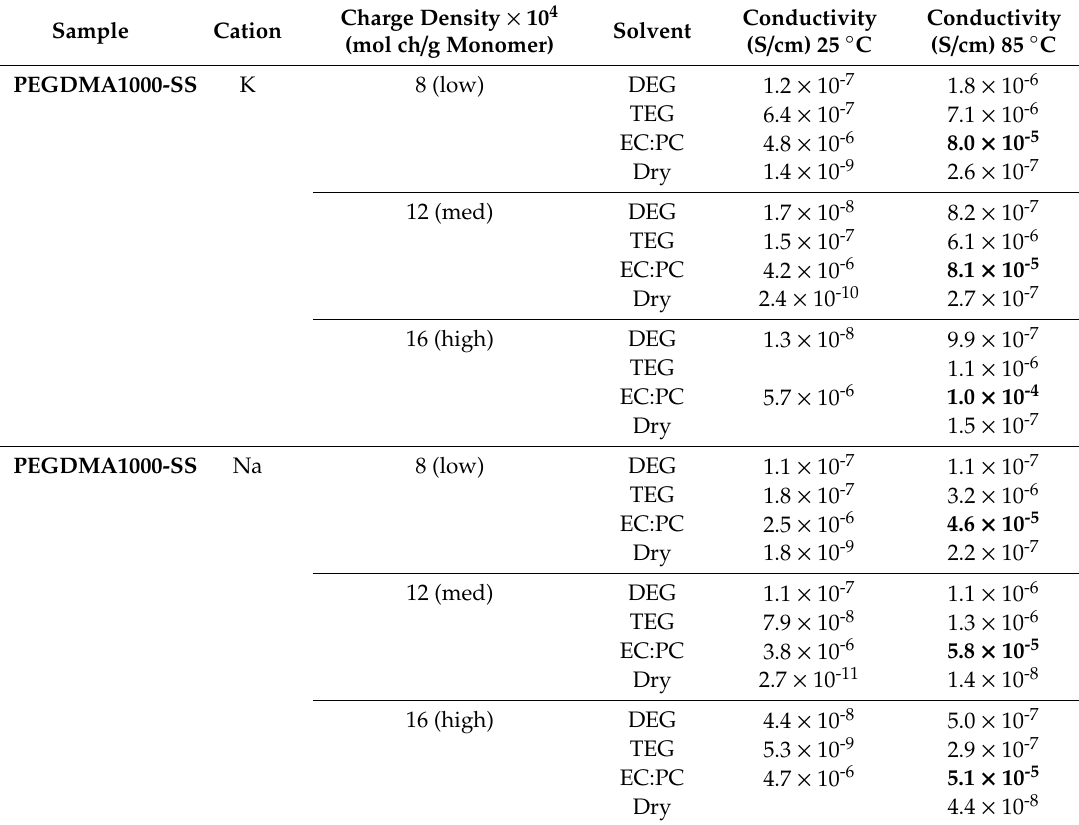
Table 4. Conductivity of all SIPEs in all conditions at 25 ◦ C and 85 ◦